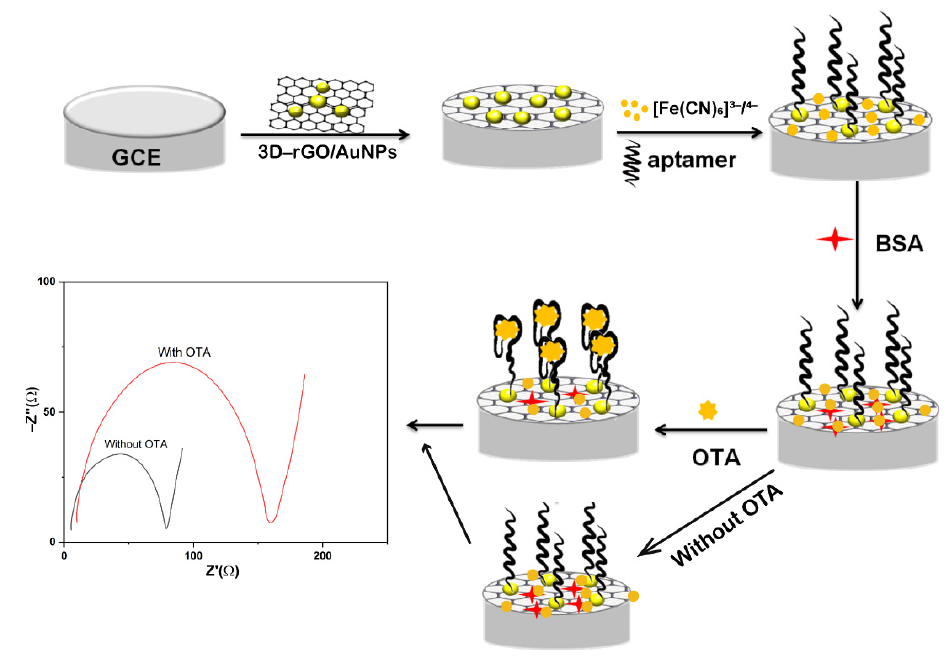
Figure 1. Schematic illustration of GCE/3D-rGO/AuNPs based aptasensor for Ochratoxin A